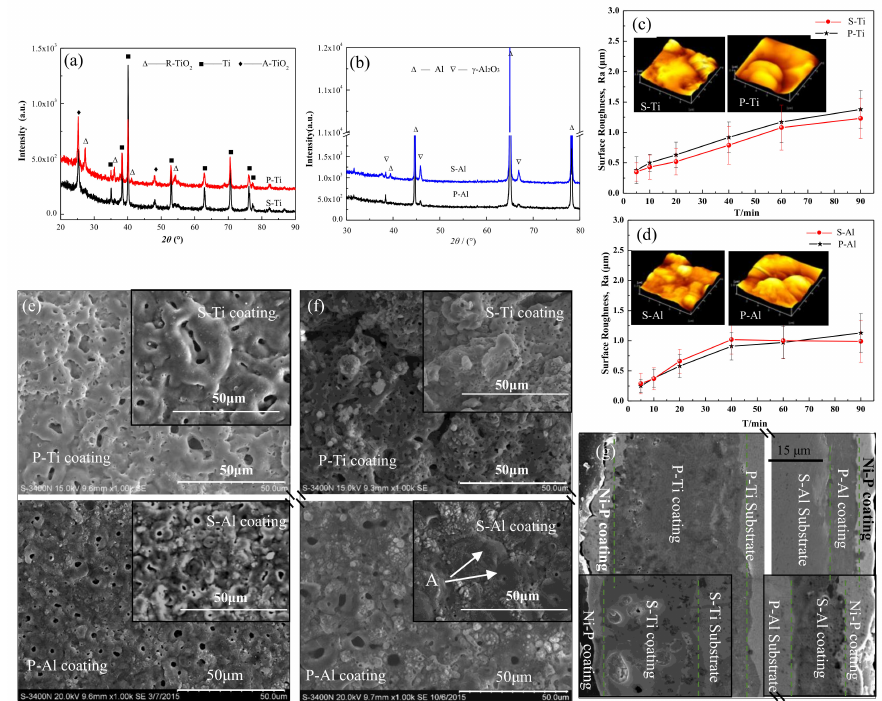
Figure 2. ( a,b ) X-ray di ff raction (XRD) patterns of di ff erent samples; ( c,d ) the change in surface roughness (Ra) with treated time (insets are the atomic force microscopy (AFM) surface topography of di ff erent coatings treated for 60 min); (e) surface morphologies of Al-Ti coating treated 10 min; ( f ) surface morphologies of Al-Ti coating treated 10 min; ( g ) cross-section Al-Ti coating treated 60 min (insets are the coatings of the single